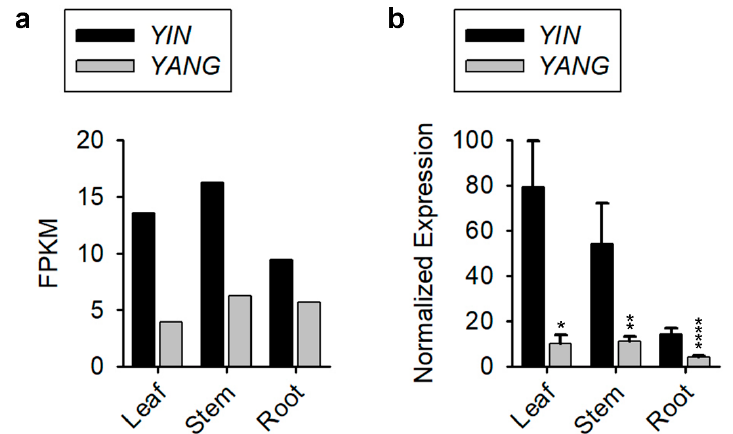
Figure 3. Expression of YIN and YANG in different tissues of Populus ( Populus trichocarpa ). ( a ) Published expression data of YIN and YANG in leaf, stem, and root from the Website (phytozome-next.jgi.doe.gov, accessed on 4 August 2022). ( b ) RT-qPCR data of YIN and YANG expression in leaf, stem, and root of 30 days old Populus (wild-type) plants cultivated in bottles. Data represent the mean ± standard error (SE) from three biological replicates (N = 3), and PtActin 7 was used as internal control. Note that the plants for the tissue samples continually grew on media with low IBA concentrations. The asterisks indicate significant differences between YIN and YANG expression (Student’s t -test: * p ≤ 0.05, ** p ≤ 0.01, and **** p ≤ 0.0001).